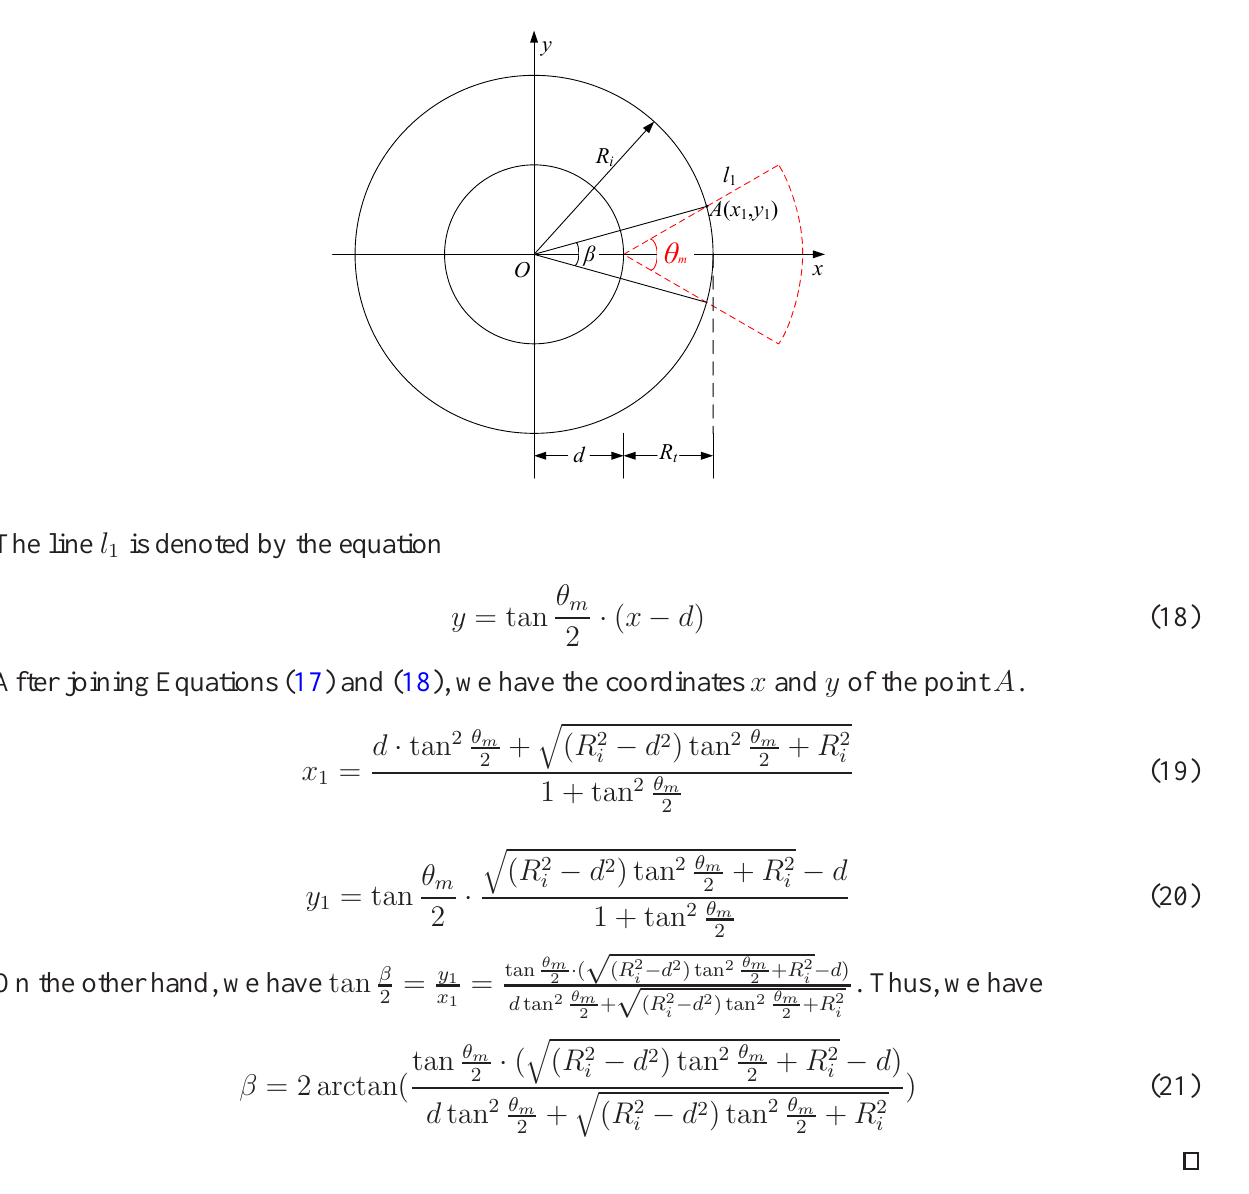
Figure A1. Calculate the coverage angle β